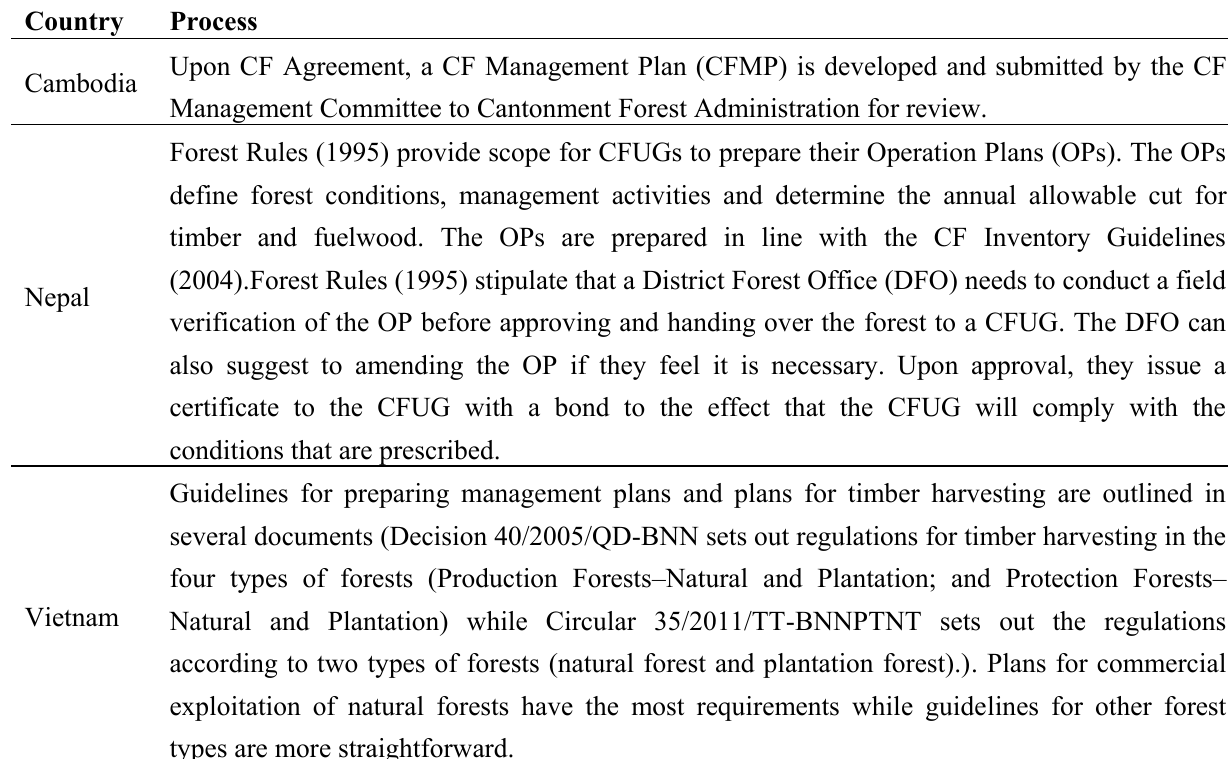
Table 3. Details of requirements for development, submission and approval of community forest management plan in each country